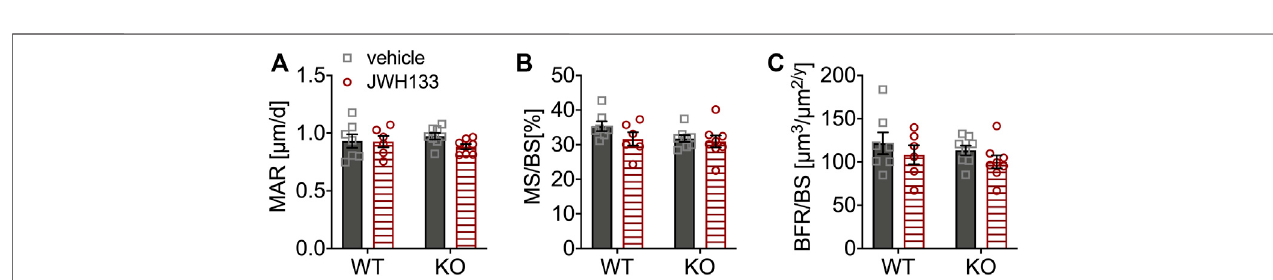
FIGURE4| BoneformationandmineralizationweresimilarbetweengenotypesandnotaffectedbyJWH133. (A) Mineralappositionrate(MAR)ofp62KOandWT mice treated with JWH133 was comparable. (B) Mineral surface per bone surface (MS/BS) showed no difference by comparing for genotype and treatment. (C) Bone formation rate per bone surface (BRF/BS) showed no effect of treatment and was comparable between genotypes. Male mice were aged 3 months by the beginning of theexperimentandweretreatedfor5 dayswithvehicleorJWH133.Datawereanalyzedbyusingordinarytwo-wayANOVAandBonferroniadjusted p nvalues,* p < 0.05,** p < 0.01,*** p < 0.001.Allerrorbarsshowmean±SEM.Squaresandcirclesrepresentindividualdatapoints.WTvehicle N =7,KOvehicle N =8,WTJWH133 N = 8, KO JWH133 N =